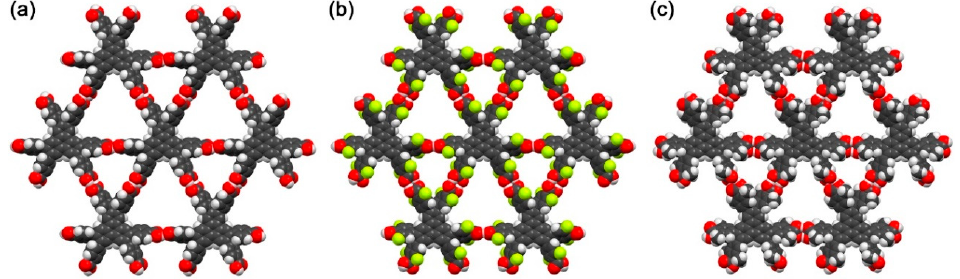
Figure 5. H-HexNet structures of: ( a ) Tp; ( b ) TpF; ( c ) TpMe. Crystallographically disordered parts in the frameworks are omitted for clarity.